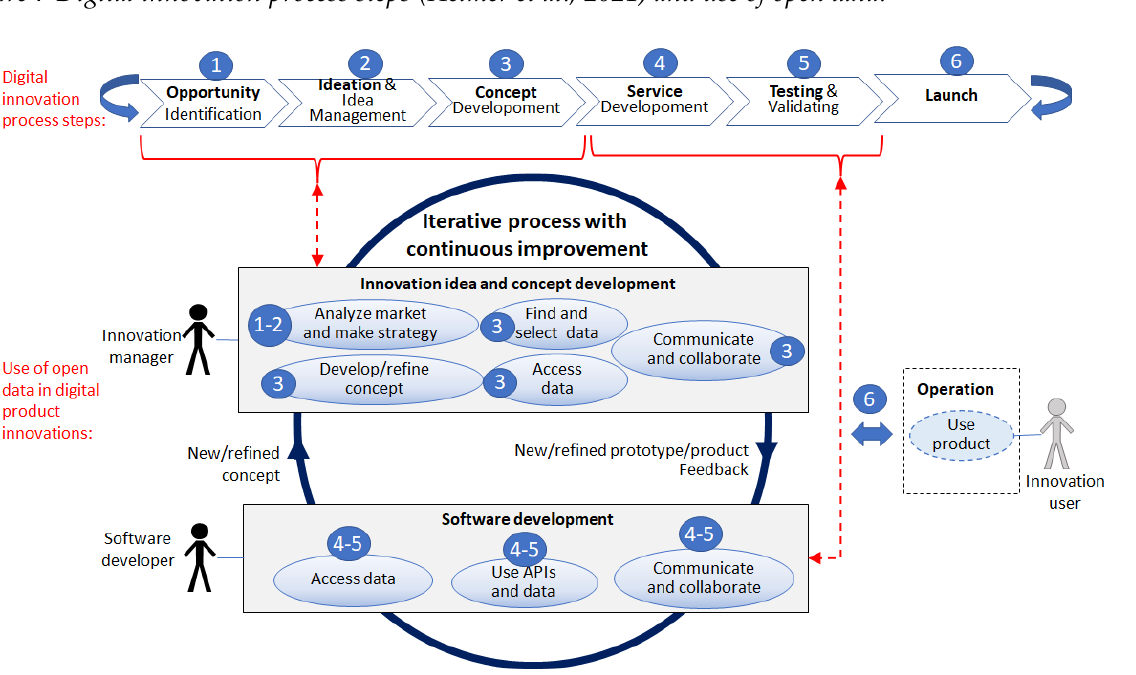
Figure 7 Digital innovation process steps (Helmer et al., 2021) and use of open